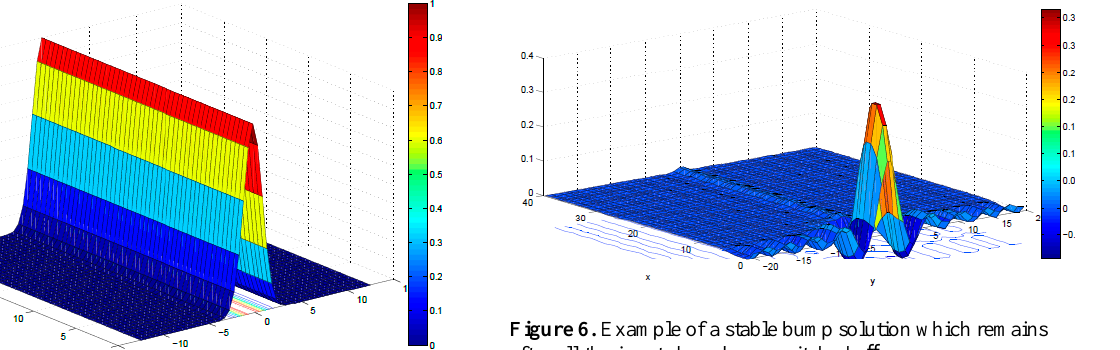
Figure 6. Example of a stable bump solution which